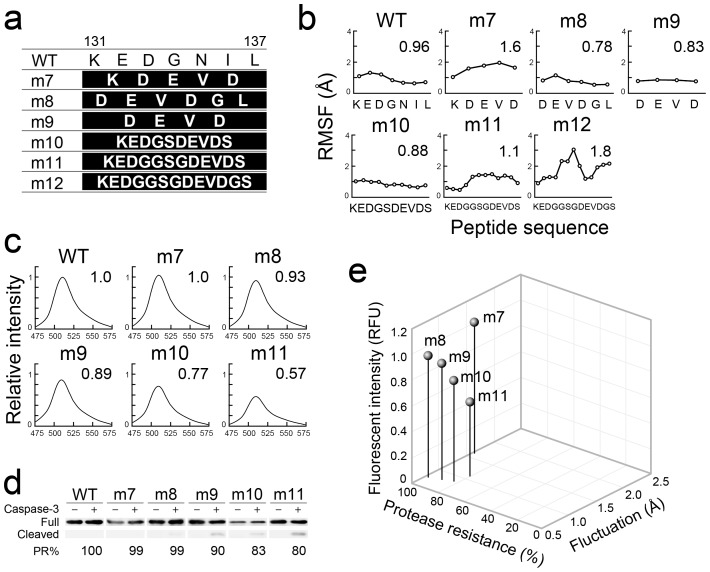
Analysis of gFPSs containing polypeptides of various lengths at K131–L137.(a) Peptide sequences of gFPSs. The amino acid sequence of sfGFP is shown at the top. The integrated peptide sequences of m7–m12 are shown in white letters. (b) Root mean square fluctuation (RMSF) values of K131–L137 in sfGFP and m7–m12 are shown. Average fluctuation distances are also indicated. (c) Fluorescence spectra following excitation at 480 nm for sfGFP and m7–m11. The fluorescence intensity of sfGFP at 510 nm was used as a reference. Relative intensities of gFPSs are also indicated. (d) Proteolytic resistance of sfGFP and m7–m11. Cleaved fragments were analyzed after 24-h treatment with caspase-3 by western blotting. Protease resistance (PR%) was calculated from the band intensity of cleaved fragments (Cleaved) compared with that of remaining full-length proteins (Full). (e) Comparison of gFPS tolerance with regard to the peptide length. The relative fluorescent intensity (RFU) at 510 nm compared with that of sfGFP, the protease resistance (%) evaluated using western blotting, and structural fluctuation (Å) of the various peptides calculated by MD simulation are shown.